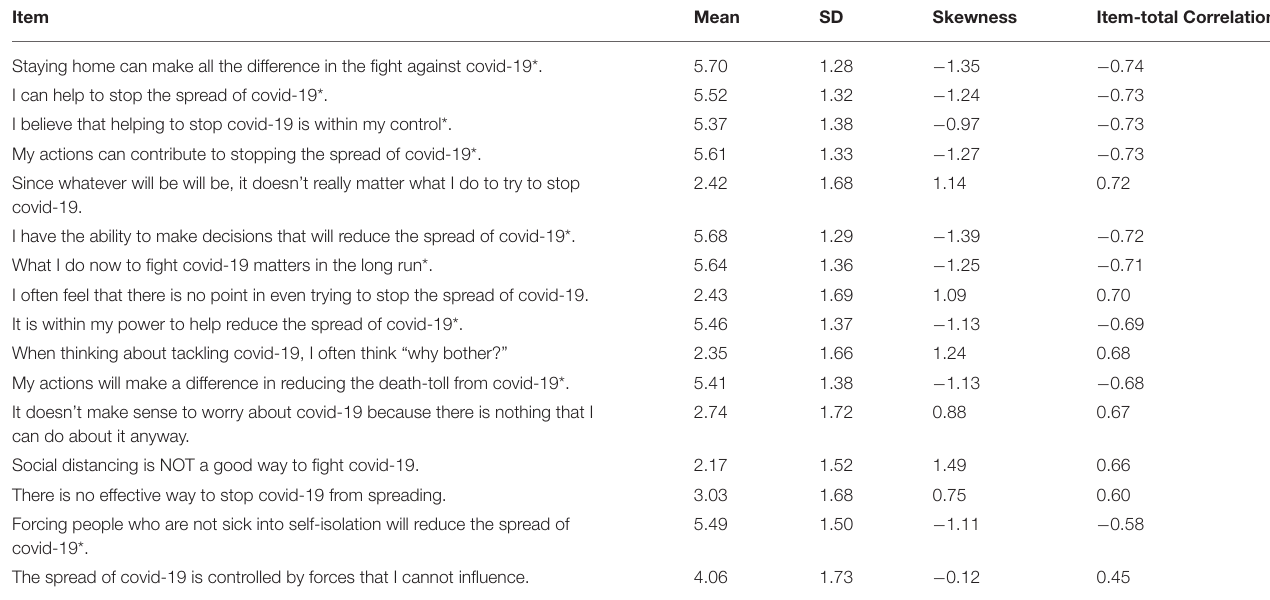
TABLE 1 | Descriptive statistics for scale items assessing fatalism toward fighting Covid-19. Item Mean SD Skewness Item-total Correlation Staying home can make all the difference in the fight against